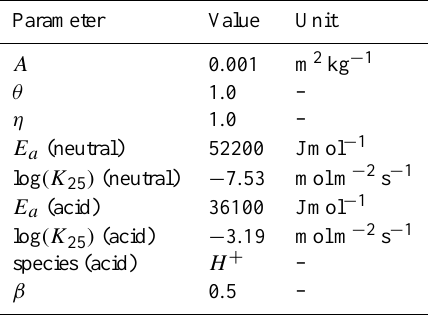
Table 1. Parameters for dolomite kinetics (from Palandri and Kharaka, 2004).